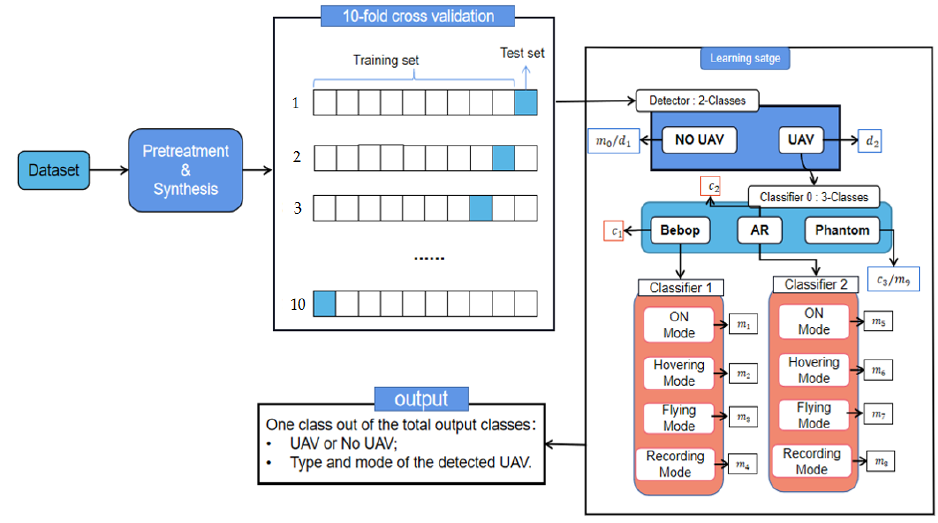
Figure 3. Our approach consists of dividing the dataset into training and testing data stage and a learning stage with four classifiers to specify the class of any sample.